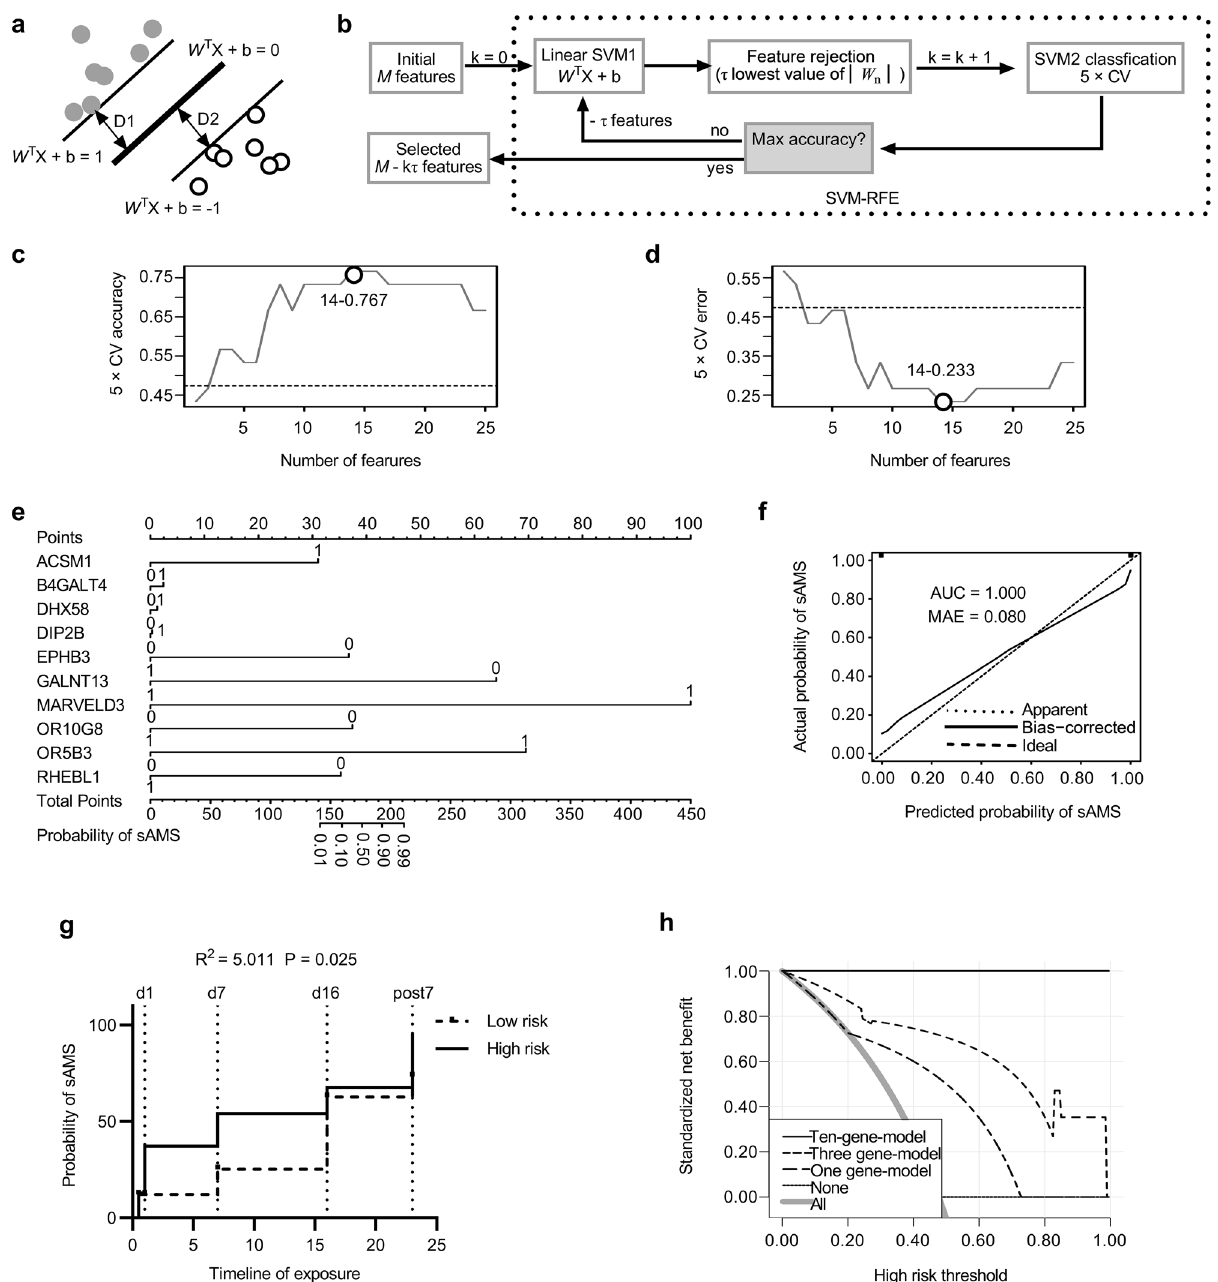
Figure 5. Establishing the model of genetic susceptibility to sAMS. ( a ) Hyperplane of SVM-RFE. Thicker line, hyperplane; thinner lines, margin limits; W T , the weight vector; X , the feature vector; b, the threshold; D1 and D2, marginal distances. ( b ) SVM-RFE method. The SVM1 parameters (absolute values of W n ) were computed to determine the relevance of all the input features, and then the entire feature selection and error estimation process were performed during SVM2 classification as a guide to choose the optimal number of features. M , number of input features; k, number of folds of CV; τ, number of features to be rejected. ( c , d ) The estimated accuracy and error. ( e ) A nomogram for the prediction of sAMS upon rapid exposure to VLH. ( f ) The calibration performance of the model. ( g ) Survival analyses for the subjects in the training cohort. ( h ) DCA of the three models. The high-risk threshold was predicted as